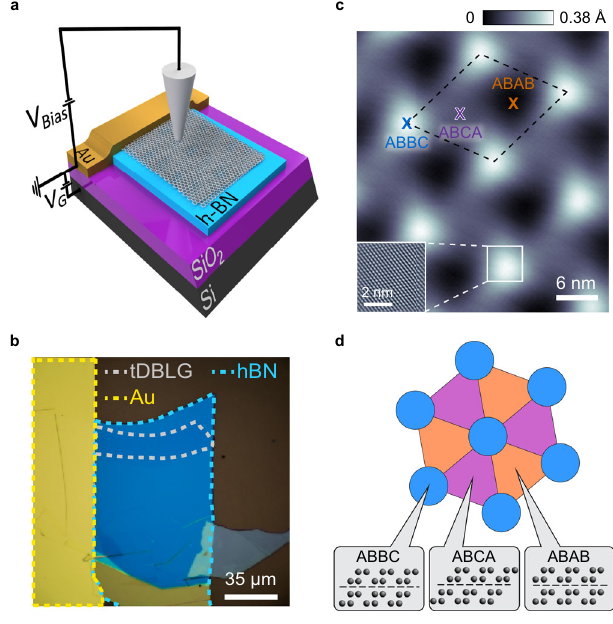
Fig. 1 Basic characterization of tDBLG. a STM/STS measurement con fi guration for tDBLG devices. The doped Si substrate acts as a back-gate to allow tuning of the device carrier density. b Optical microscope image of a tDBLG device. c STM topographic image of tDBLG with a twist angle θ ≈ 1.08° ( V Bias = – 250 mV, I 0 = 0.25 nA). The dashed box outlines the moiré unit cell. Inset: zoom-in image showing graphene atomic lattice. d Sketch of tDBLG moiré pattern showing three distinct stacking orders. The inner two layers of carbon atoms are on top of each other for ABBC stacking whereas they are Bernal-stacked for ABCA and ABAB